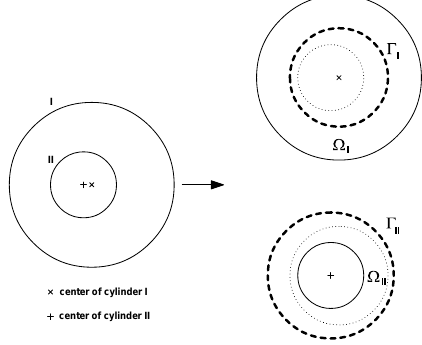
Figure 2. Eccentric cylinders